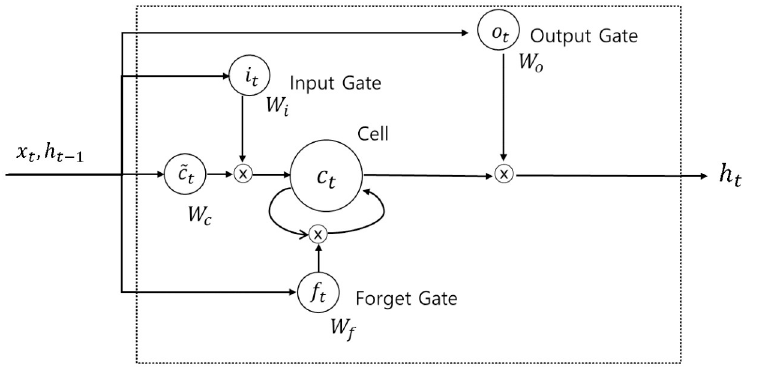
Fig 9. Memory block of